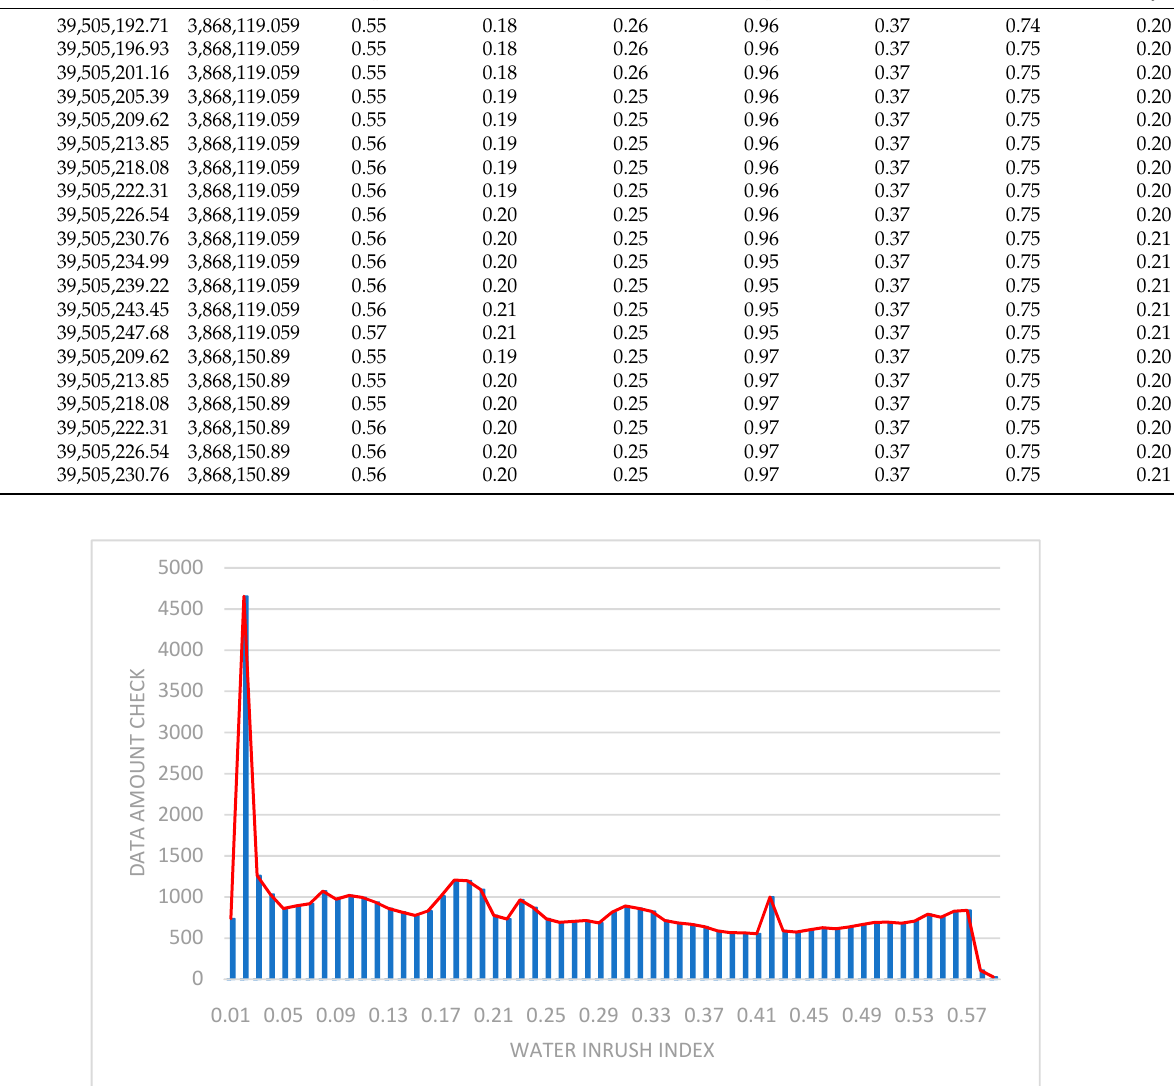
Figure 6. Frequency histogram of water inrush index.